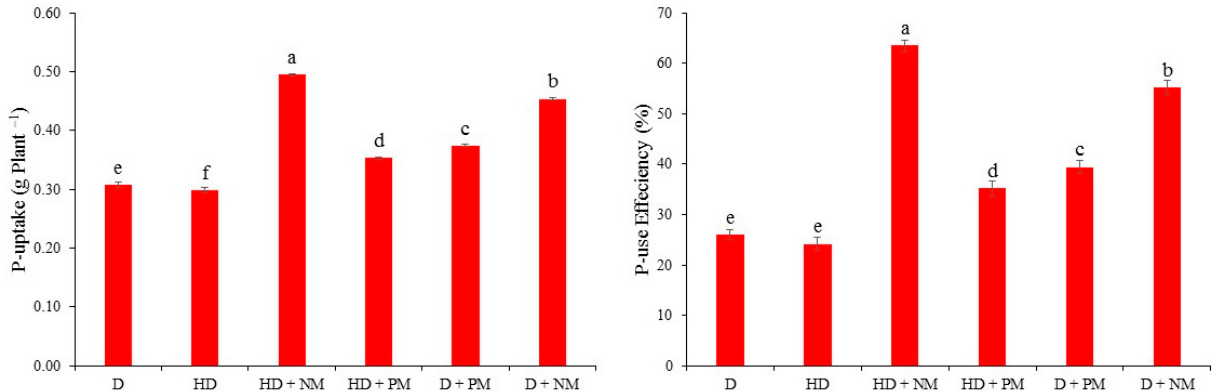
Figure 5. Effect of animal manures with DAP fertilizer on plant phosphorus contents uptake (%) and phosphorus use efficiency (%). D: Recommended DAP; HD: Half of the recommended dose of DAP; NM: Normal manure; PM: Processed manure. Figure bars are showing the mean values ( n = 3). All means followed by different letters have statistically significant differences according to Tukey’s HSD test at probability level of 0.05.